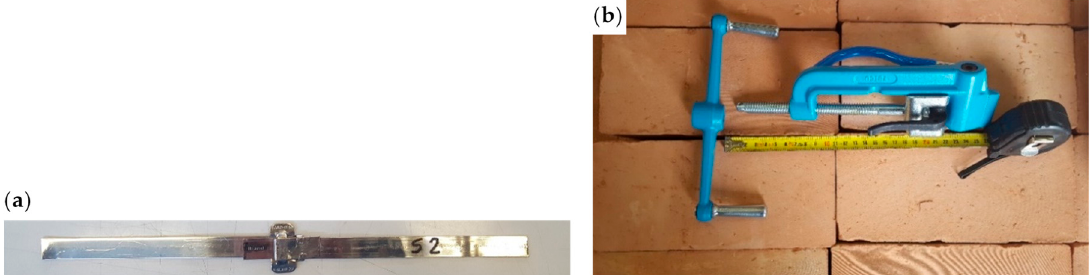
Figure 8. The fastening system of Reference [1]: ( a ) one fastened specimen for the characterization of the junctions and ( b ) the manual strapping tool used to fasten the steel ribbons.